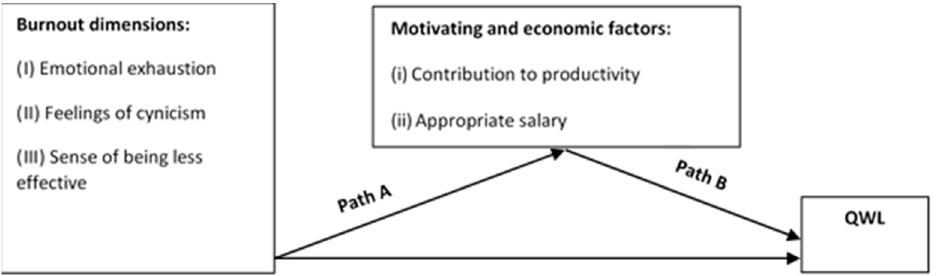
Figure 1. Mediators of burnout and QWL: Model design.